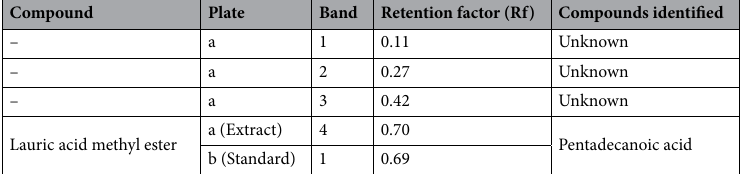
Table 7. Retention factor determined by TLC for Macrotermes carbonarius defense fluid, calculated from plate a and compared to the retention factor of the standard in plate b.